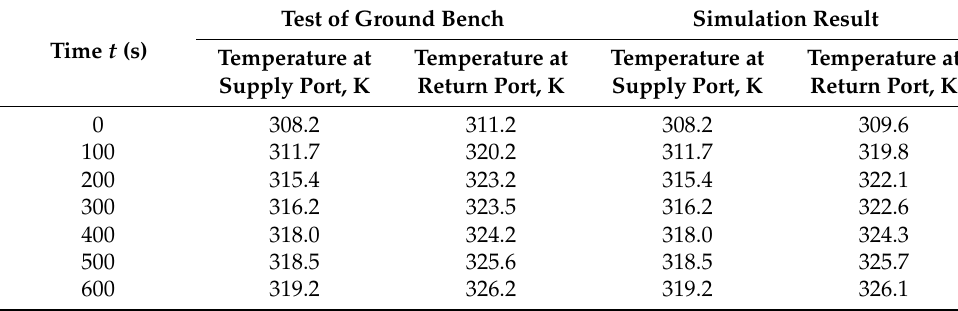
Table 4. The comparison between test of ground bench and simulation